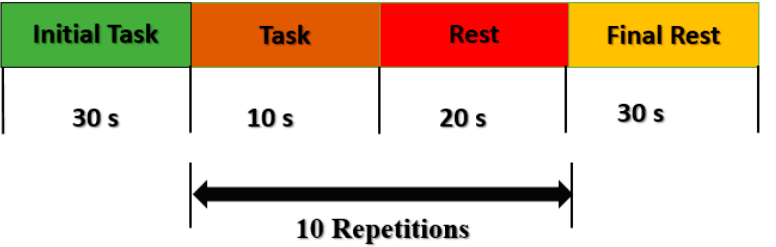
Figure 3. Experimental paradigm for data acquisition: after an initial 30 s rest, a single trial consisted of a 10 s period of walking followed by a 20 s rest.